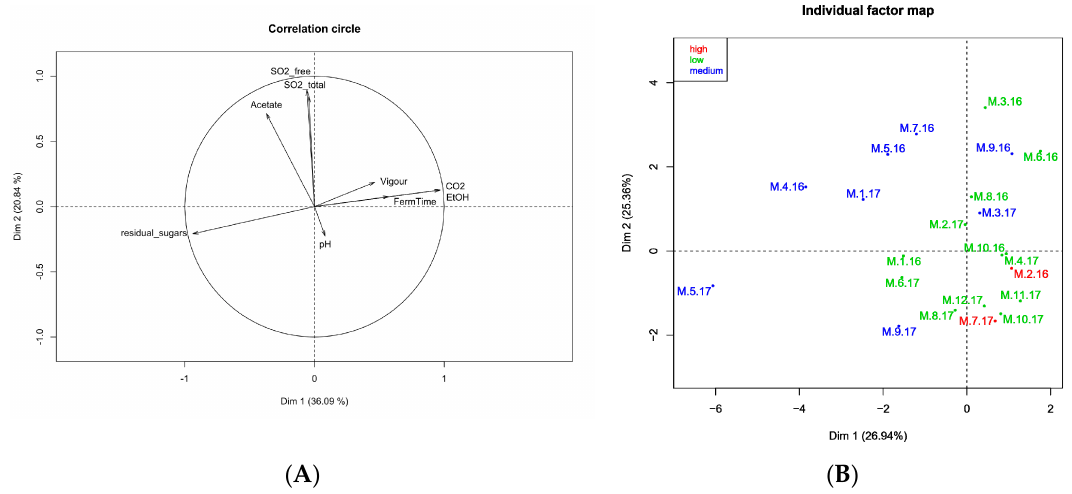
Figure 7. Correlation plots. ( A ) Relationship between the quantitative variables. ( B ) Individual factor map evaluating the dispersion of the yeast strains depending on the qualitative variable of ‘H 2 S